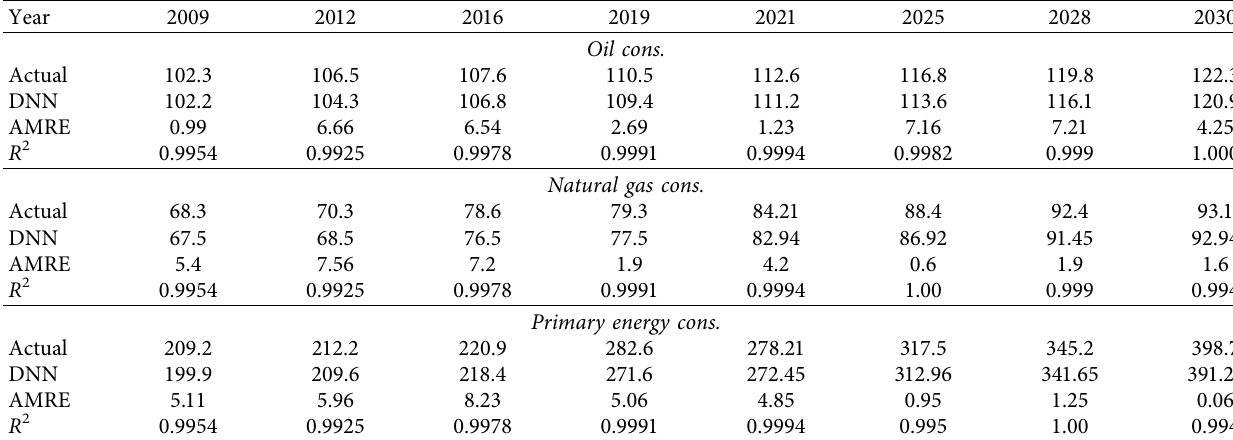
Table 1: Result of traditional energy consumption.